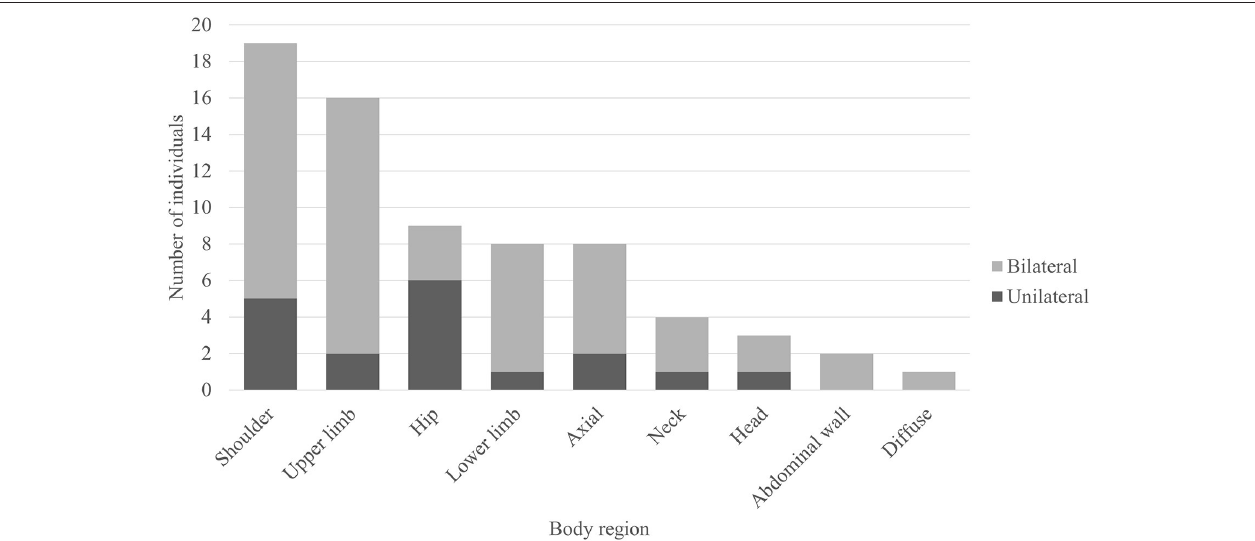
FIGURE 3 | Regions of muscle hypermetabolism on body FDG-PET. Bar graph demonstrating the frequency of regional muscle fluorodeoxyglucose (FDG) avidity in individuals with anti-glutamic acid decarboxylase-65-related neurologic disorder. Shoulder = girdle, infraspinatus, supraspinatus, subscapularis, teres complex. Upper limb = biceps, forearms, deltoids, hands. Hip = iliopsoas, iliacus, psoas. Lower limb = thighs (anterior and posterior compartments), visualized tibialis anterior, gastrocnemius, and soleus. Axial = pectoralis muscles/chest wall, paravertebral muscles (thoracic and/or lumbar regions), gluteal muscles. Neck = paravertebral muscles (cervical region), scalene. Head = occiput. Abdominal wall = obliques, arcus